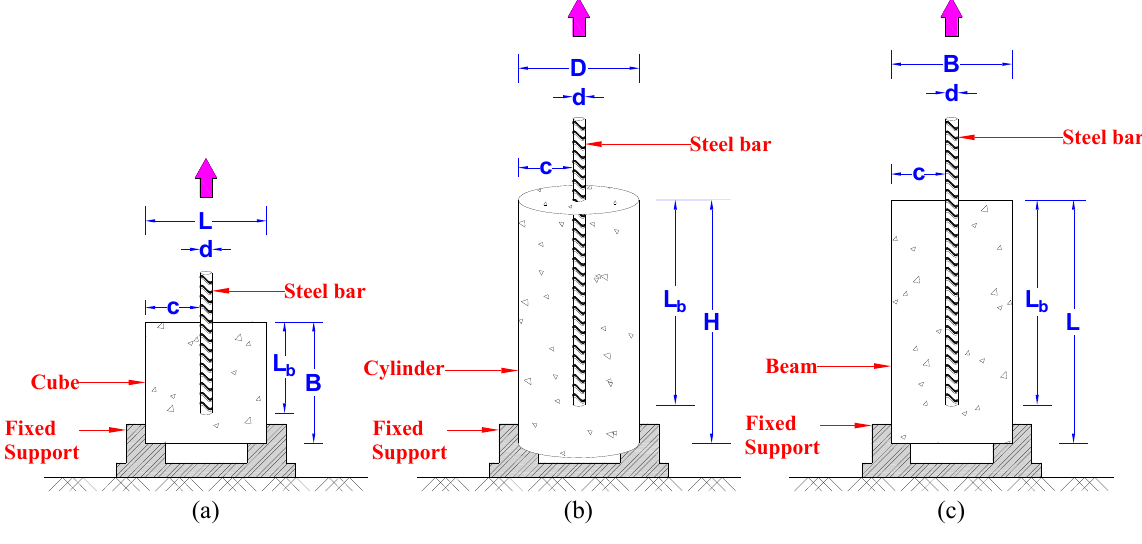
Figure 1. Pullout test setup; ( a ) cube, ( b ) cylinder, ( c ) beam specimens.